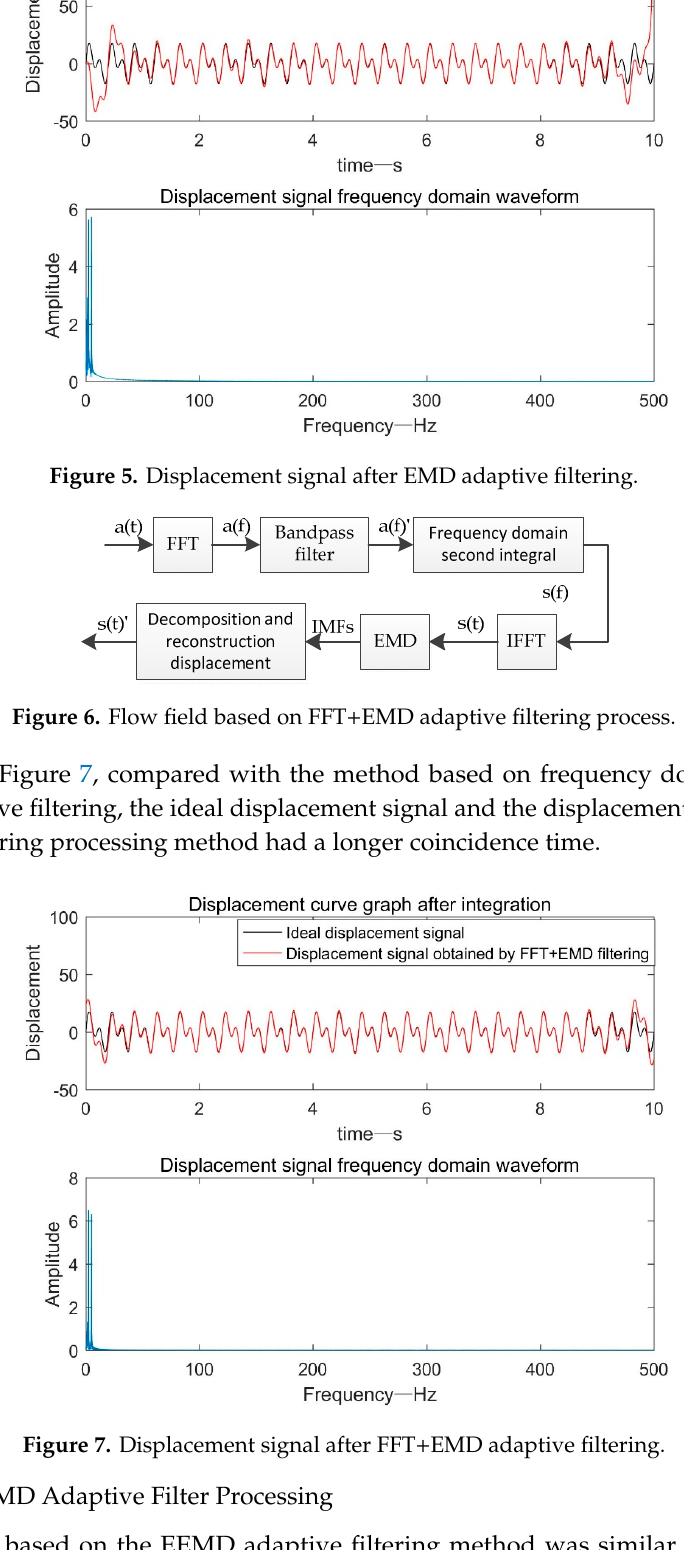
Figure 4. Flow field based on EMD adaptive filtering process.